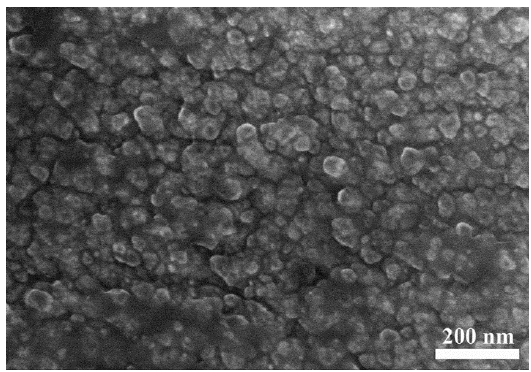
Figure 2. Surface morphology of the Ag-2Mg-2Al alloy activated at 600 °C for 30 min at an oxygen pressure of 15.0 Pa.